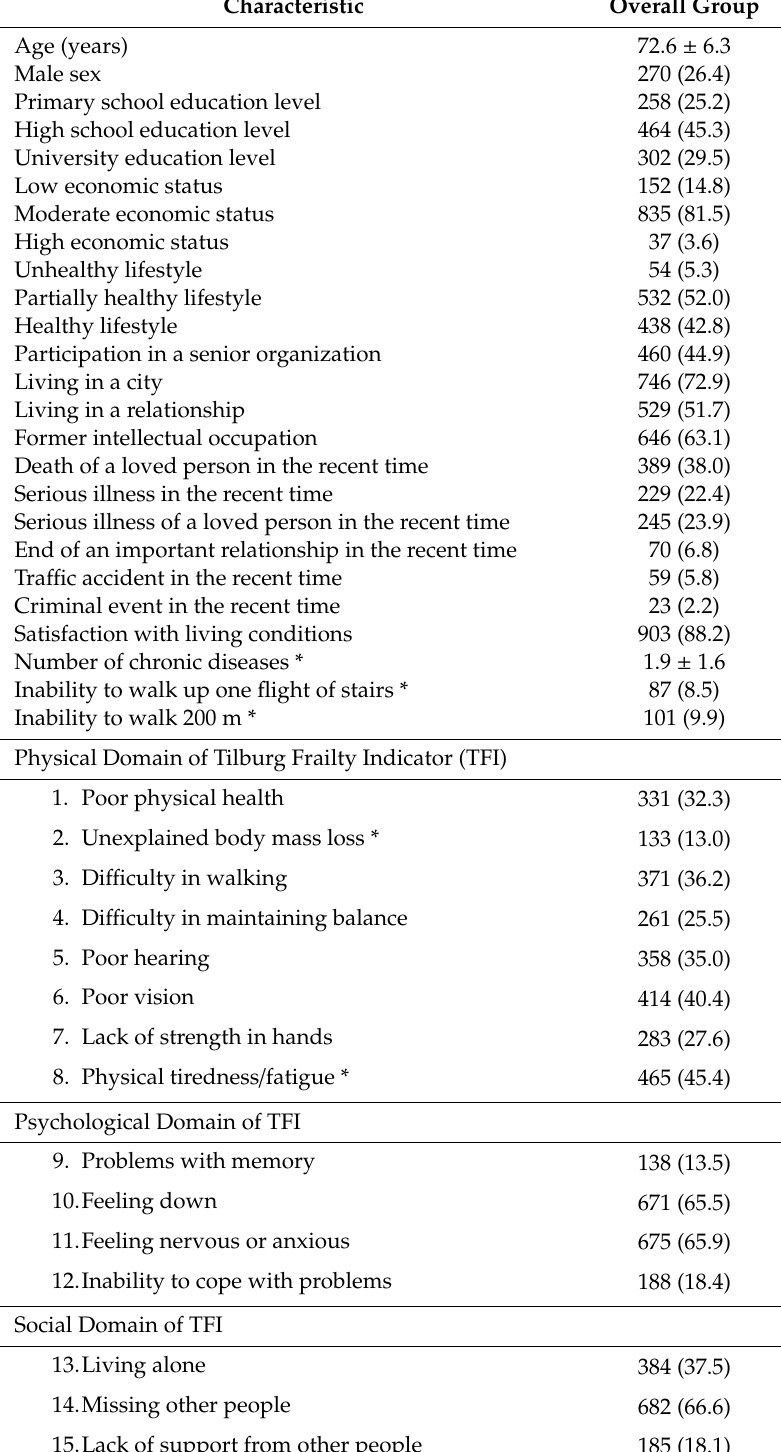
Table 1. Study group